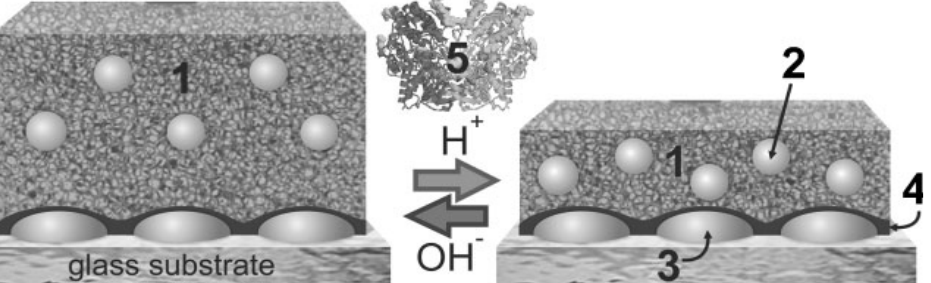
Figure 7. Ultrathin alginate-gelatin gel film (1) with silver nanoparticles (2) immobilized on silver nanoislands (3) via a poly(glycidyl methacrylate) layer (4). The film undergoes a reversible swelling transition in response to pH changes caused by the biocatalytic reaction of GOx (5) and glucose (Reproduced with permission from